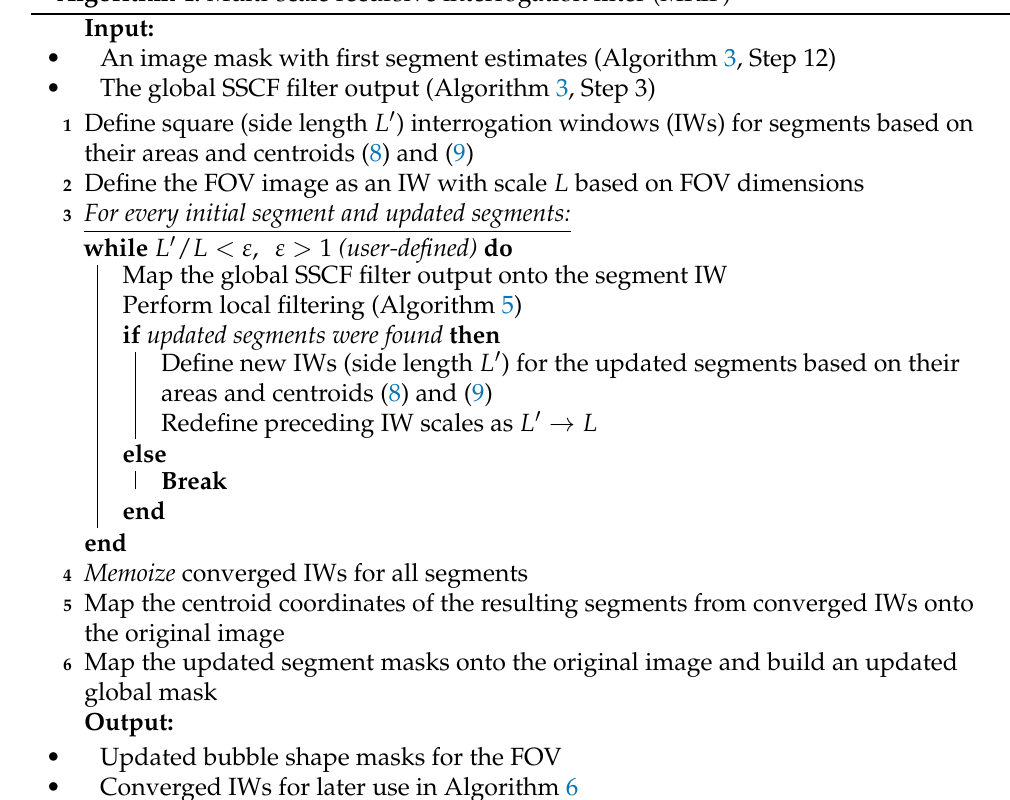
Algorithm 4: Multi-scale recursive interrogation filter